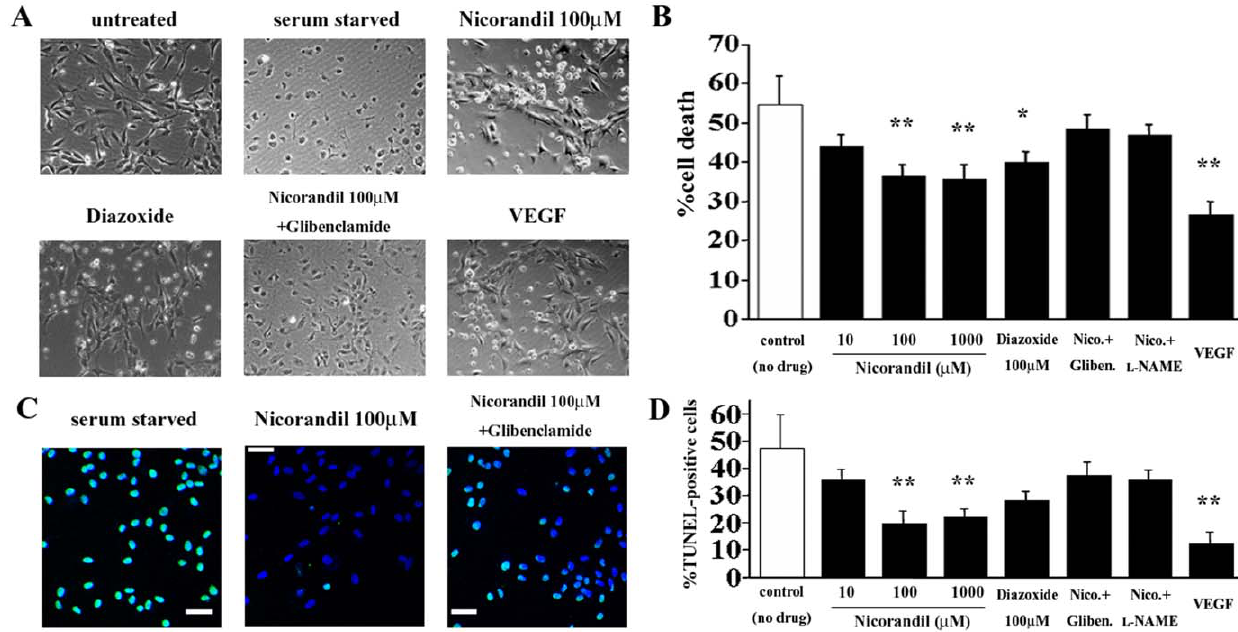
Figure 7. Nicorandil prevents the induction of vascular endothelial cell apoptosis in vitro. ( A ) The HUVECs were incubated in the serum- free medium in the absence or presence of nicorandil (10–1000 m mol/L) for 48 h. The serum-starved HUVECs exhibited apoptotic morphology, which is characterized by cell shrinkage ( see ‘‘serum starved’’). ( B ) The viability of the HUVECs was measured with the MTS assay, and the percent cell death was calculated. Stimulation with nicorandil and diazoxide partially restored cell viability in a concentration-dependent manner. VEGF, vascular endothelial growth factor (positive control). * P , 0.05 and ** P , 0.01 vs. control (no drug). ( C ) TUNEL staining revealed that a large number of the serum-starved HUVECs exhibited apoptotic morphology (left), and the apoptotic effects induced by serum starvation were attenuated by nicorandil (middle). TUNEL (green); nuclei (blue). ( D ) The TUNEL-positive nuclei in the serum-starved HUVECs were counted in 10 randomly selected fields and expressed as a percentage of the total number of nuclei. ** P , 0.01 vs. control (no drug).